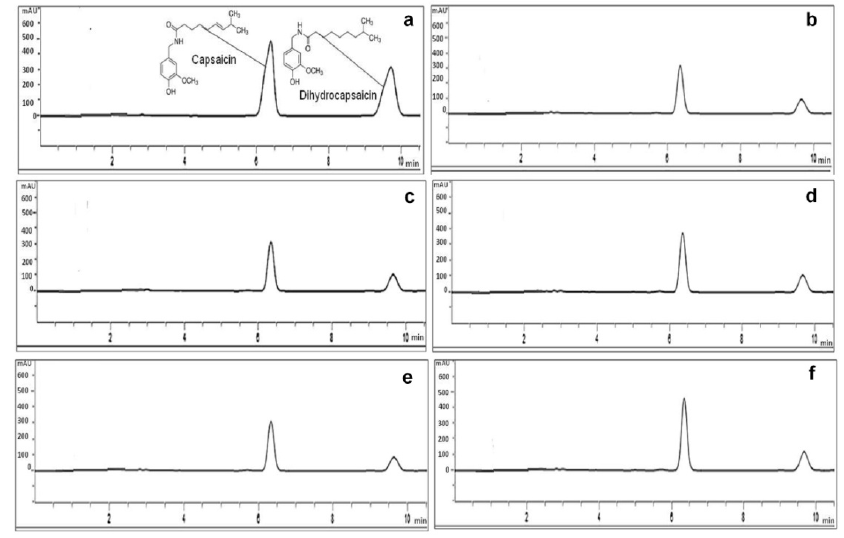
Figure 4. Chromatograms for capsaicin and dihydrocapsaicin in habanero pepper fruits from plants treated with ZnO NPs and ZnSO 4 , ( a ) standards, ( b ) control, ( c ) 1000 mg L − 1 ZnSO 4 , ( d ) 1000 mg L − 1 ZnO NPs, ( e ) 2000 mg L − 1 ZnSO 4 , ( f ) 2000 mg L − 1 ZnO NPs.